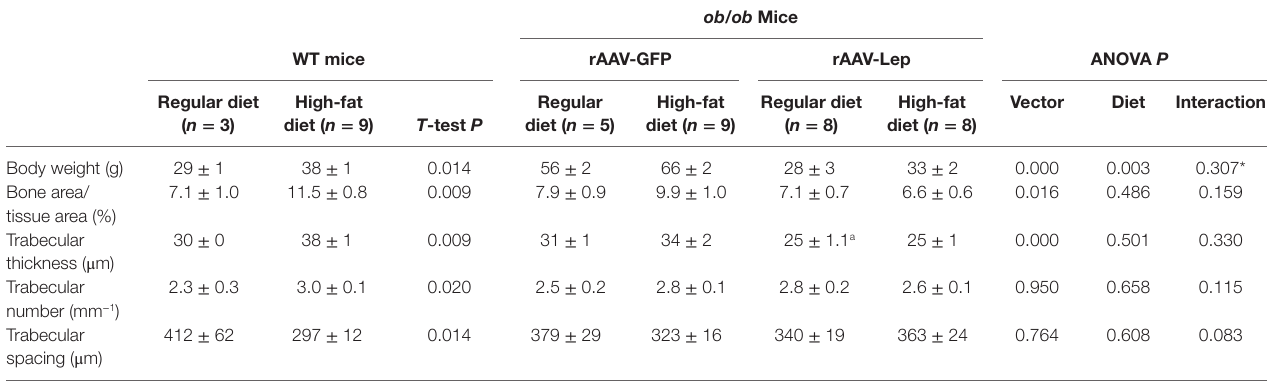
TaBle 2 | effects of high-fat diet and raaV-lep pretreatment and high fat diet on terminal body weight and cancellous bone architecture in distal femur metaphysis in male WT and ob/ob mice,